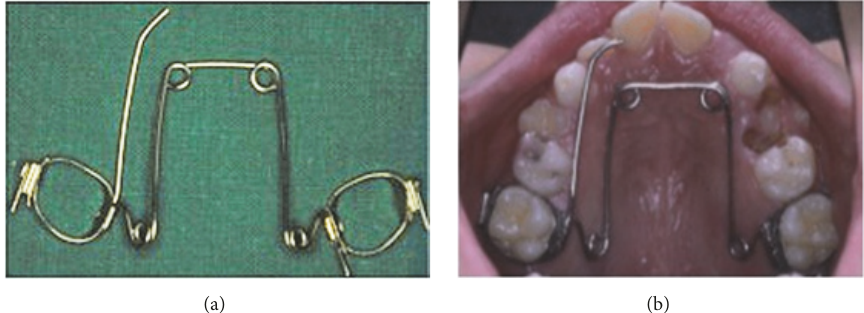
Figure 6: Asymmetric Quad Helix: extraoral (a) and intraoral (b) views. When the auxiliary wire segment is applied into the mouth, it must not interfere either with the mucosa or with the band in order to not give rise to undesired positions or